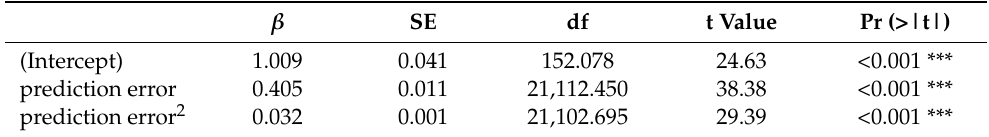
Table 4. The result of quadratic regression model.